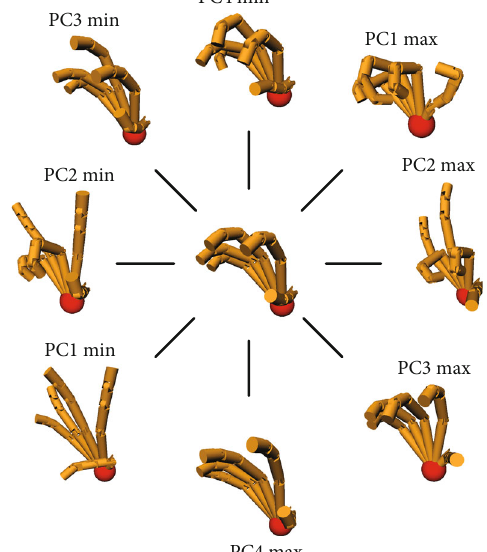
Figure 8: Movement characteristics along PC1 ~